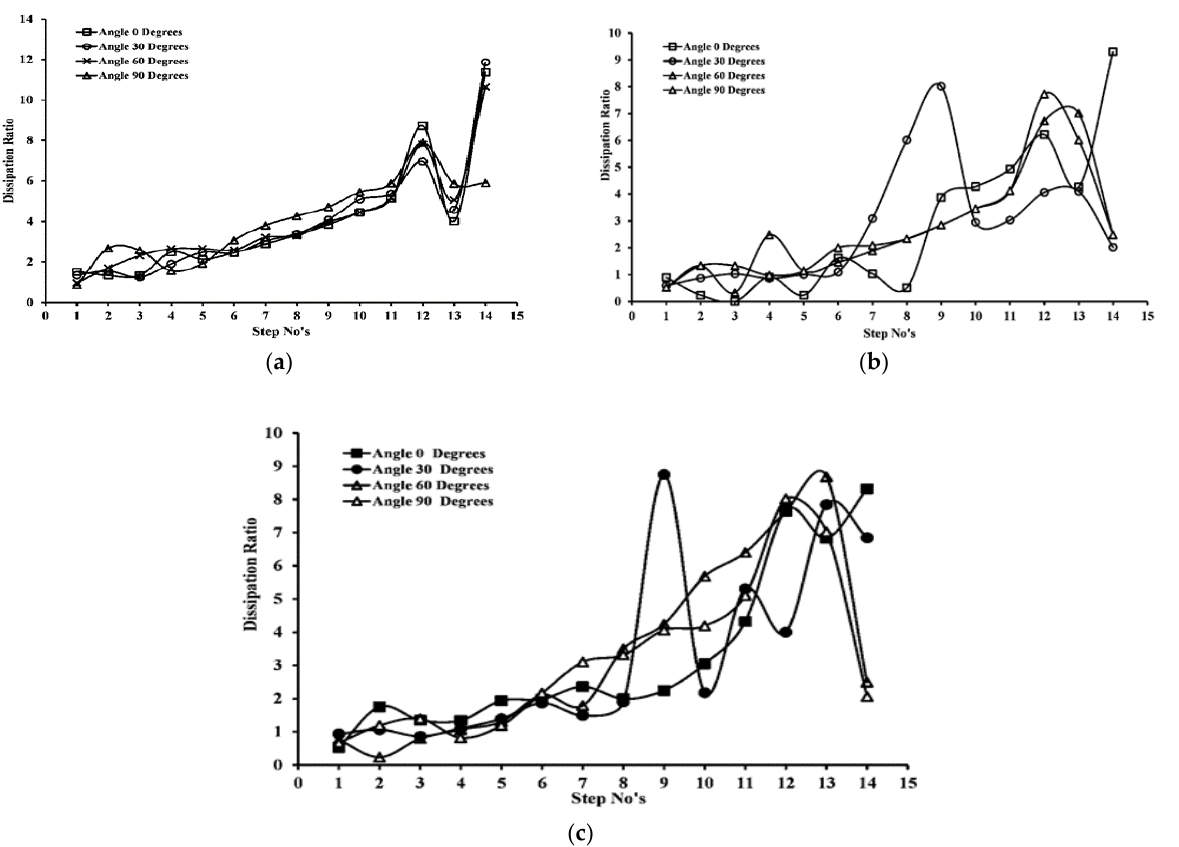
Figure 16. ( a ).EDD for the Q = 0.042 m 3 /s. ( b ). EDD for the Q = 0.059 m 3 /s. (c). EDD for the Q = 0.068 m3/s. 0.068